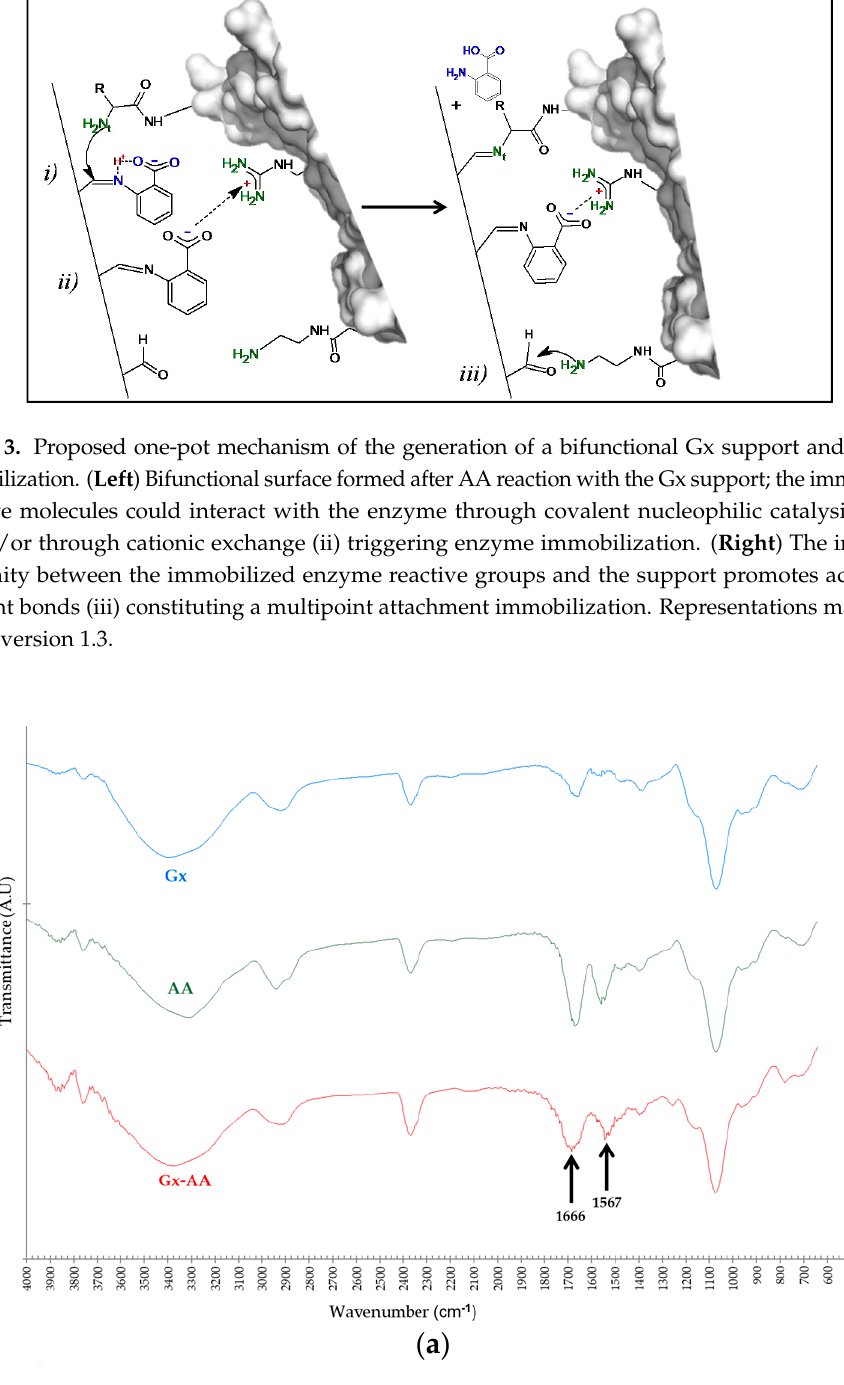
( b ) Figure 4. ( a ) Comparative FTIR-ATR transmittance spectra of Gx support derivatives: plain Gx support without modifications (Gx, blue), pure anthranilic acid (AA, green), and Gx anthranilic acid derivative support (Gx–AA, red); ( b ) Comparative UV-Vis spectra: free AA spectra (brown), plain Gx support (Gx, orange), Gx after treatment with 20 mM AA (green), Gx after fuchsine staining (grey), Gx after treatment with AA 20 mM and then stained with fuchsine (blue).